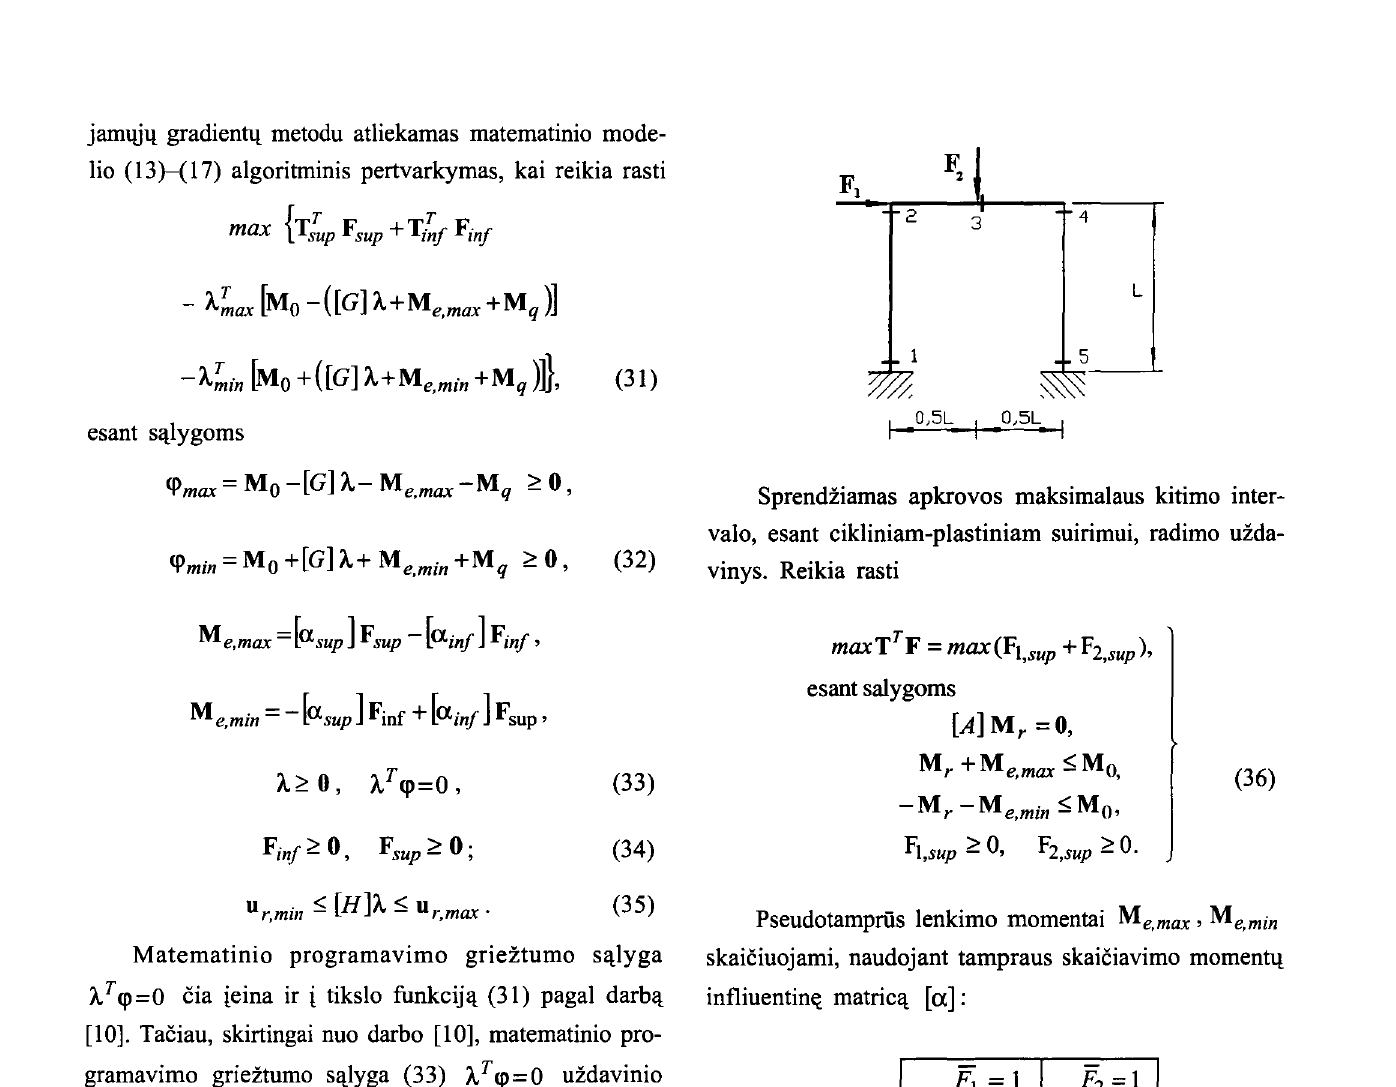
A. T <p=O . Siuo atveju Rozeno a1goritmas ir tiesiniq ta kumo s~t1ygq atveju dirba stabi1iai.